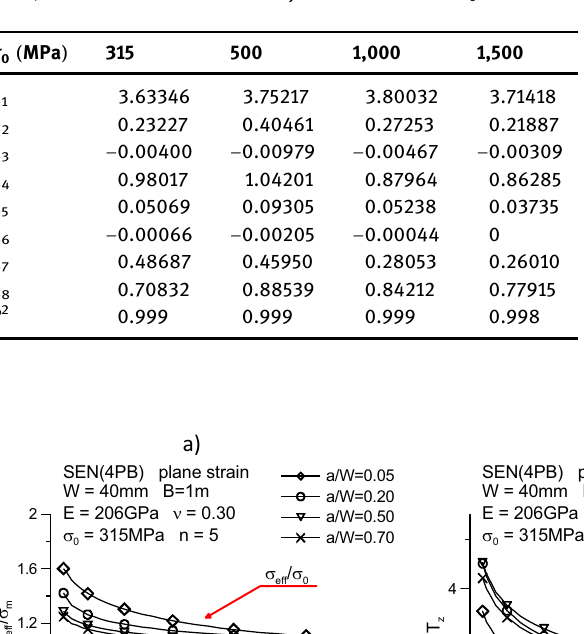
Table 10: Coe ffi cients of matching the formula ( 27 ) to the numerical results for SEN ( 4PB ) specimens dominated by the plane strain state, for materials with di ff erent yield stress values σ 0